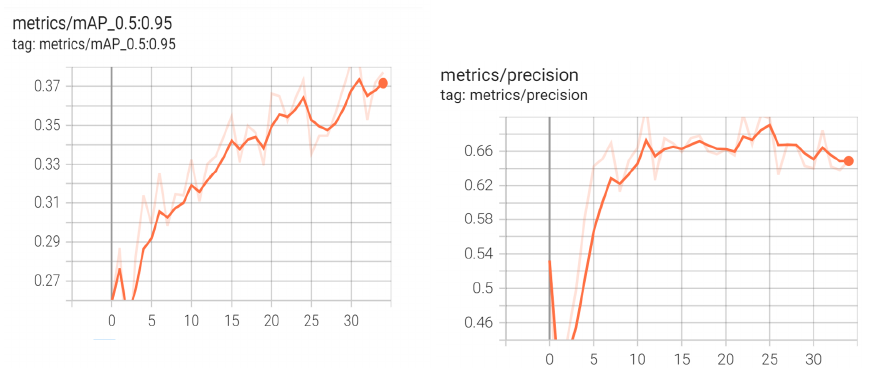
Figure 23. YOLOv5 training and validation graphs.